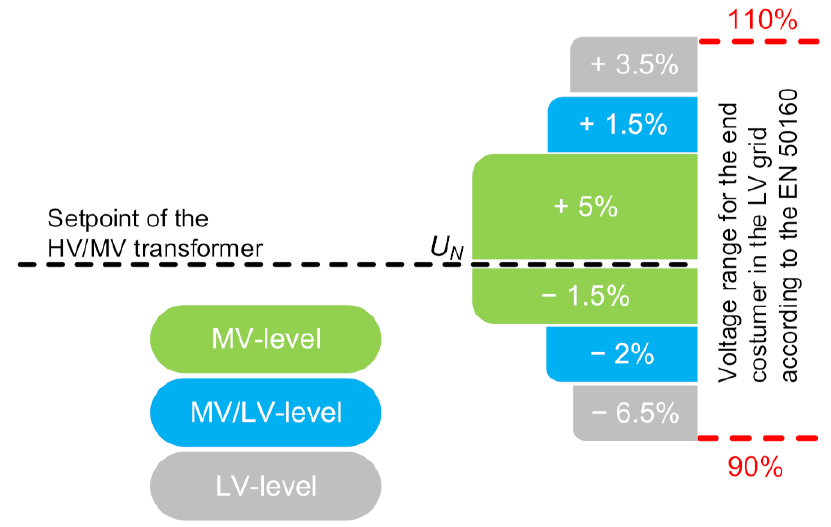
Figure 1. Allowed voltage ranges in the normal state depending on the voltage level